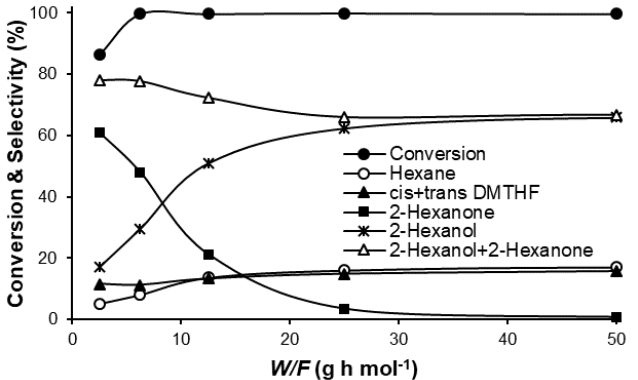
Figure 3. Plot of DMF conversion and product selectivity versus contact time W / F for hydroconversion of DMF (7.0%Pt / C + SiO 2 catalyst (0.20 g), 1.6 kPa DMF partial pressure, 70 ◦ C, 20 mL · min − 1 H 2 flow rate, 1 h TOS; the W / F was varied by varying the amount of 7.0%Pt / C in the Pt / C + SiO 2